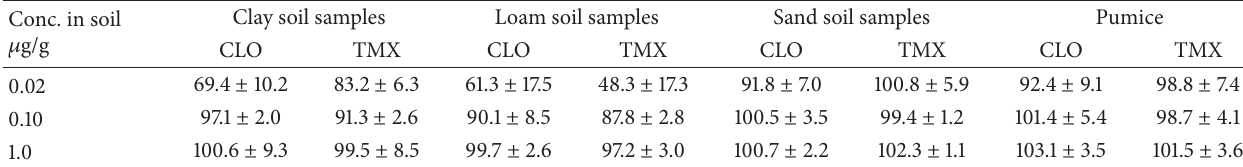
Table 1: Recoveries in the modified QuEChERS method at three